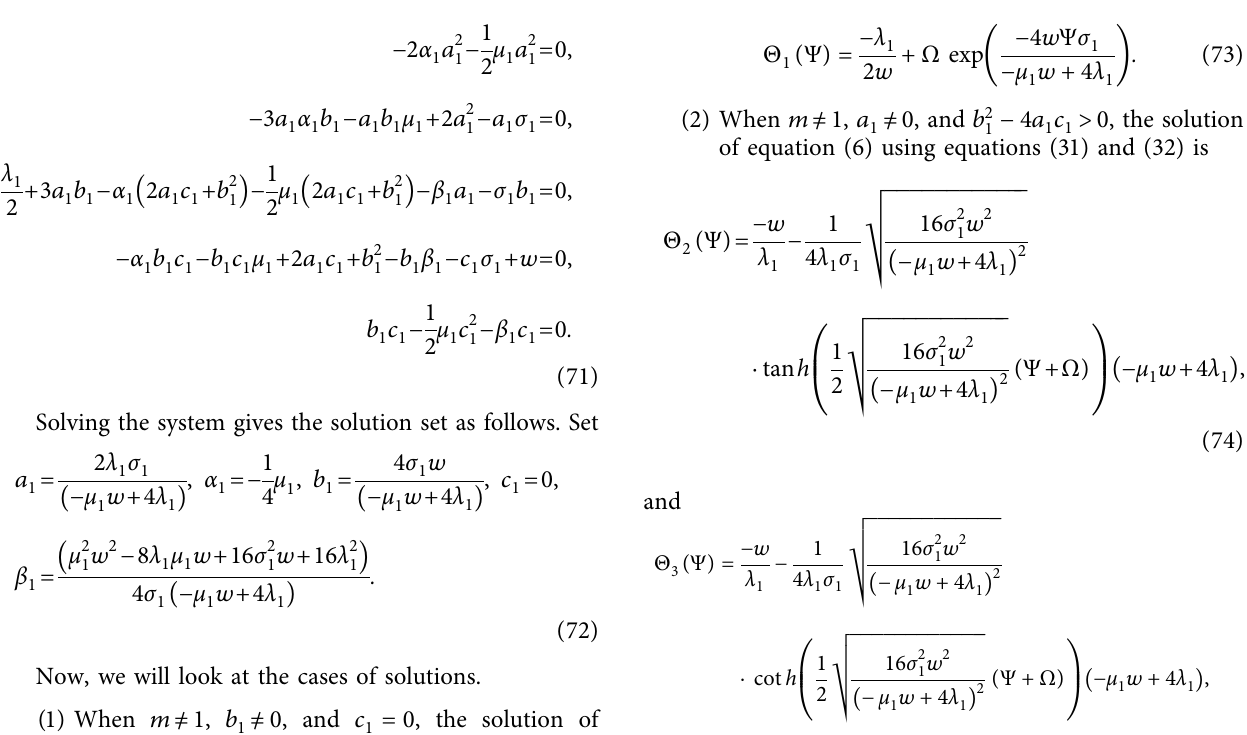
� 0 . 3, and w � 0 . 3. (a) Θ 241 , (b) Θ 242 , (c) Θ 241 , Θ 242 1